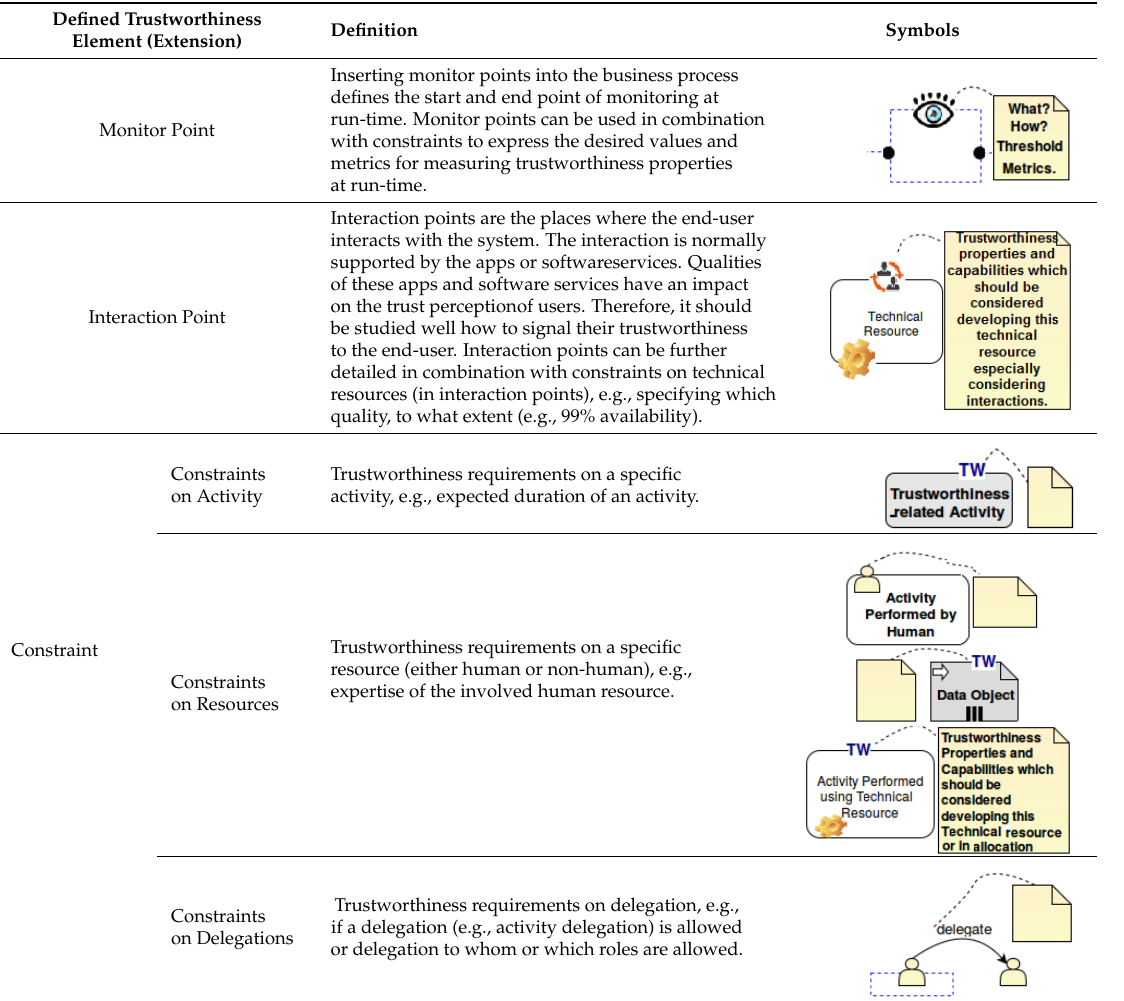
Table 1. Extended elements to model trustworthiness requirements in